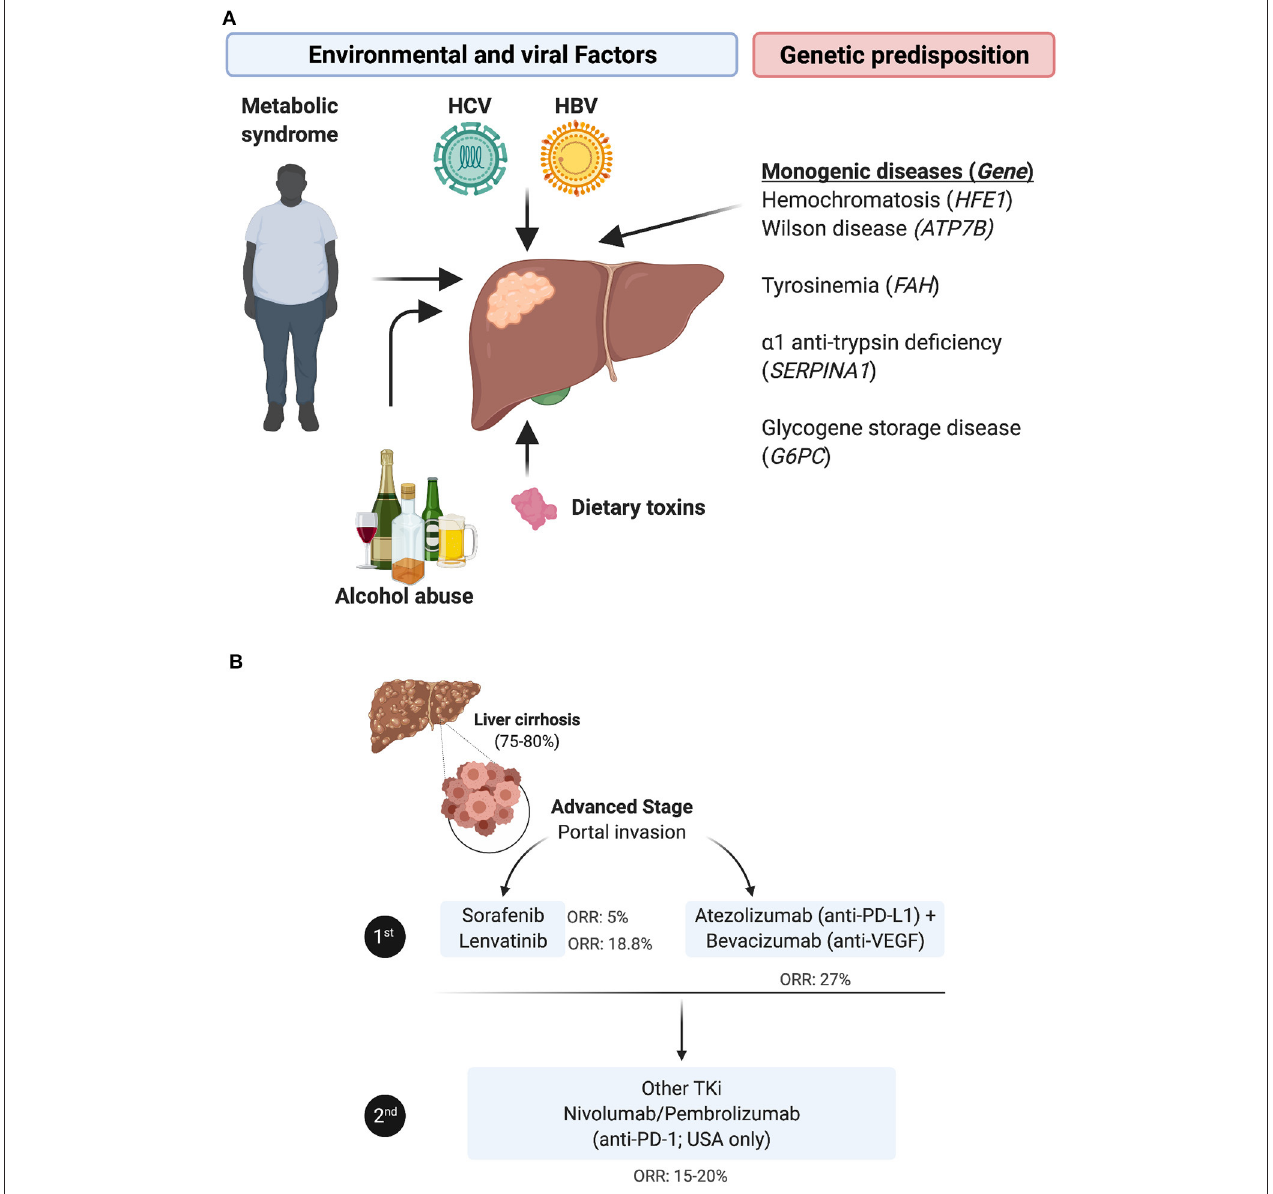
FIGURE 1 | HCC etiologies, genetic predisposition and current standard of care for the advanced stage. (A) HCC etiologies include chronic infection with HBV or HCV, alcohol abuse, dietary toxins and/or the metabolic syndrome linked to obesity and type 2 diabetes. In rare cases, HCC stems from a monogenic disease e.g., hemochromatosis, caused by mutations in the homeostatic iron regulator gene HFE1 ; Wilson disease involving mutations in the ATPase copper transporting beta gene ATP7B ; tyrosinemia, resulting from mutations in the gene encoding fumarylacetoacetate hydrolase FAH , α 1-trypsin deficiency caused by mutations in serpin family A member 1 SERPINA1; or glycogen storage disease, in which the glucose-6-phosphatase gene is mutated. (B) The standard of care for treating patients with advanced HCC has been revised with the approval of immune checkpoint inhibitors. In first line, patients are administered TKi, mainly sorafenib or lenvatinib, or given the newly approved combination of bevacizumab (anti-VEGF) + atezolizumab (anti-PD-L1). In second line, patients refractory to TKi are treated with other TKIs, whereas anti-PD-1 ICI, nivolumab or pembrolizumab, have only been approved in the USA as an option for second line (despite the lack of superior efficacity in phase III trials compared to